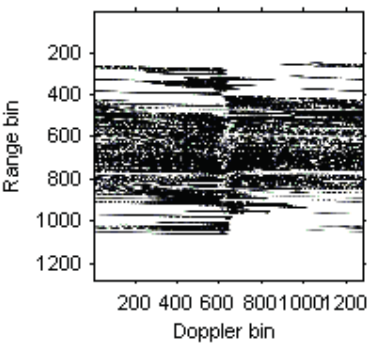
Figure 6. Radar image based on the RD algorithm.